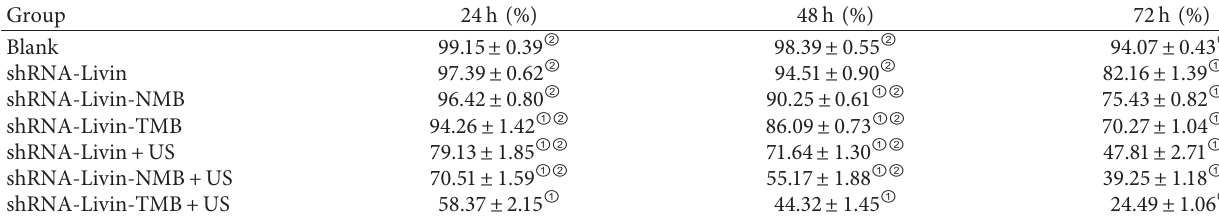
Table 1: Cell survival rate of each group at different culture time points.